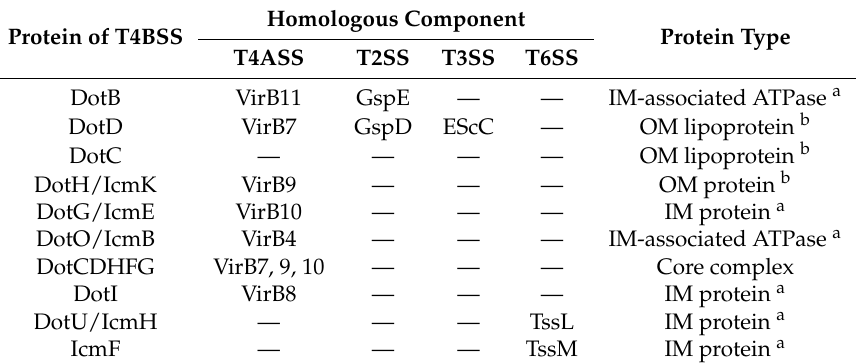
Table 2. Homologous proteins in T4BSS and other secretion